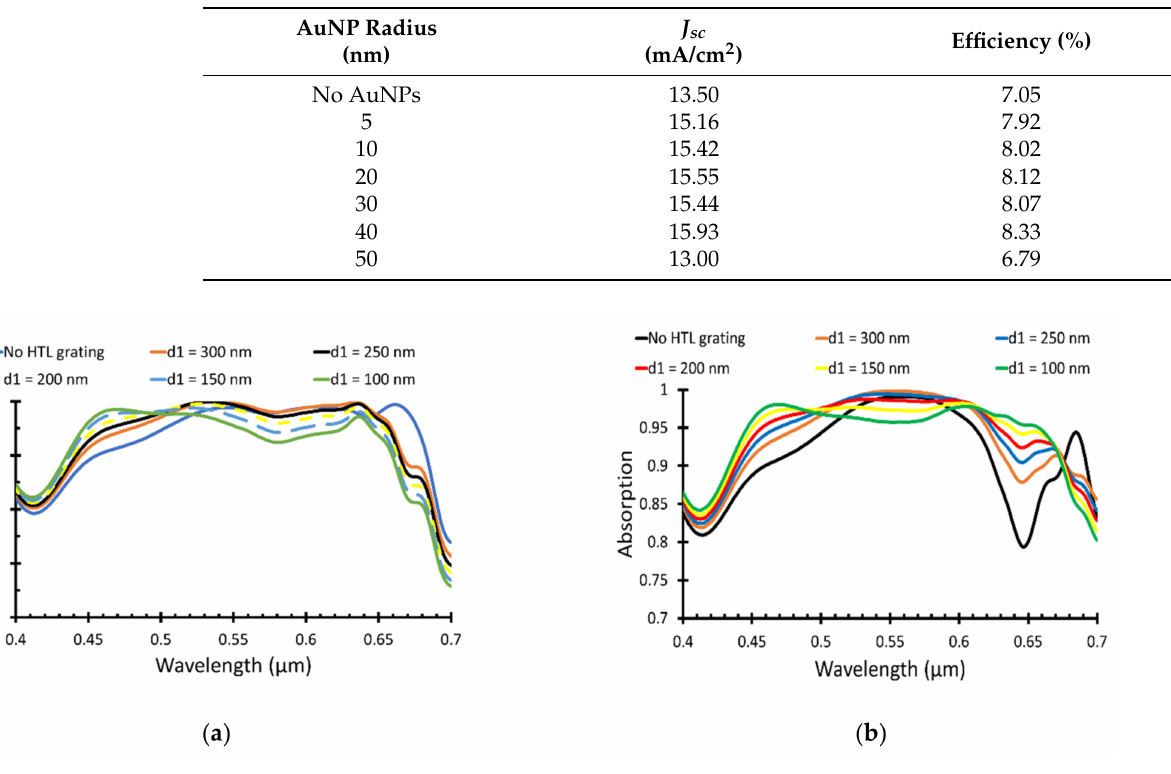
Figure 4. Light absorption ( a ) at NP radius of 30 nm and ( b ) at NP radius of 40 nm. Table 3. J sc and PCE at AuNP radii of 30 nm and 40